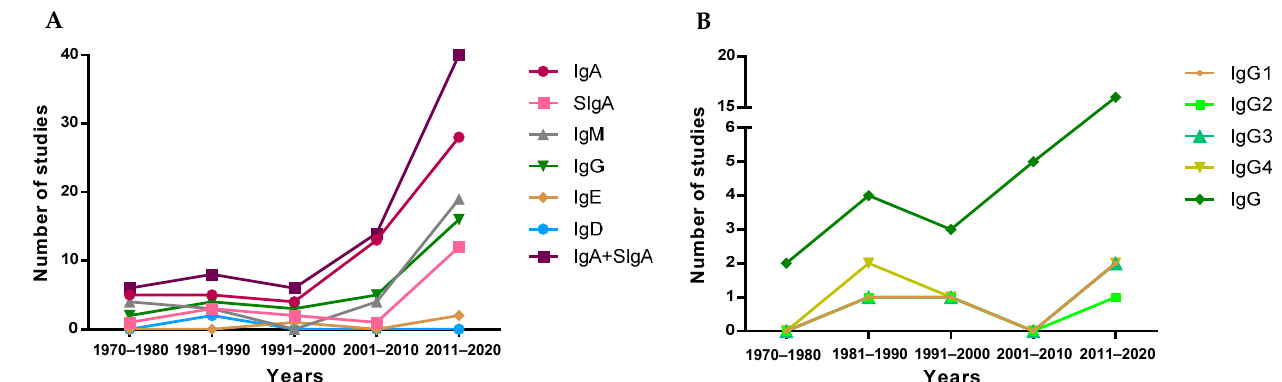
Figure 3. Evolution of the number of studies quantifying Ig types ( A ) and IgG subtypes ( B ) over the years.